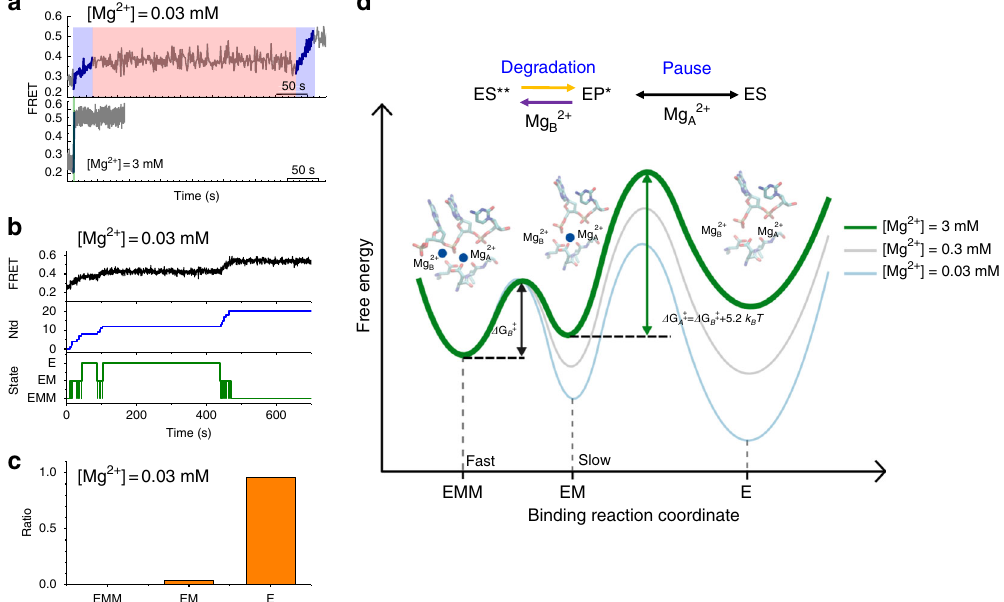
Fig. 5 FRET time trajectories and the free energy landscape during metal-ion dynamics. a Two experimental FRET time trajectories, showing Mg B 2 + -dynamics-dependent slope change (purple) and a pause caused by the dissociation of two metal ions, Mg A 2 + and Mg B 2 + (pink). b A representative simulation trajectory, displaying three panels: a time-FRET trace (black line in the top panel), degradation position of exonuclease along DNA (the line in the middle panel), and its metal-ion state (green line in the bottom panel). The trajectory revealed that iteration between EM and EMM decreases the degradation slope in a Mg 2 + -dependent manner, and pauses occur due to the E state by dissociation of both metal ions. c Total fraction of single-molecule traces showing the pause state at three different Mg 2 + states. d Free energy landscape along the reaction coordination of Mg 2 + binding and dissociation. Processive degradation occurs during a repetitive cycle between the 1 st and 2 nd metal-ion binding states, whereas a pause occurs due to the dissociation of two metal ions. The energy barrier between the 2 nd and 1 st states is lower than the one between the 1 st and 2 nd states due to the different numbers of ligands surviving after the translocation (e.g., 1 versus 3 ligands with protein residues for Mg B 2 + and Mg A 2 + , respectively). Transitions between ES** and EP* are indicated by two one-directional arrows to emphasize the transitions are non-reversible and not in